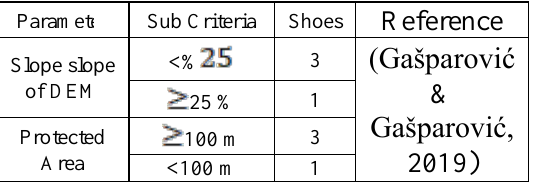
Table 2 Spatial Aspect Parameters and